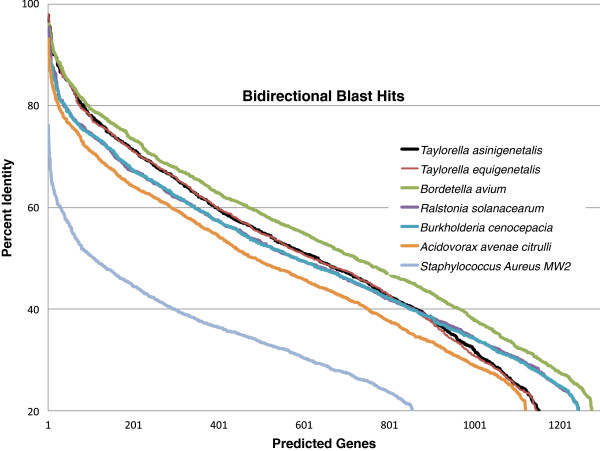
Bidirectional BLASTp hits between predicted genes for DSM 24701 and those of closely related fully sequenced genomes, calculated by RAST as the percent identity of the BLASTp hit (highest-scoring pair of segments).